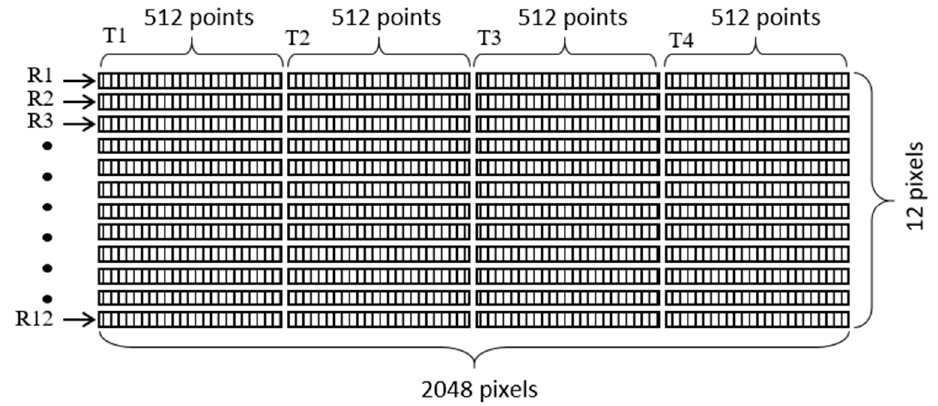
Figure 8. Construction of input image to CNN model for acoustic tactile position sensing. Image has dimensions of 12 × 2048 pixels corresponding to finger-touch-induced changes in acoustic waveforms received by 12 receivers (R1 to R12), following sequential generation of acoustic waves by four transmitters (T1 to T4).